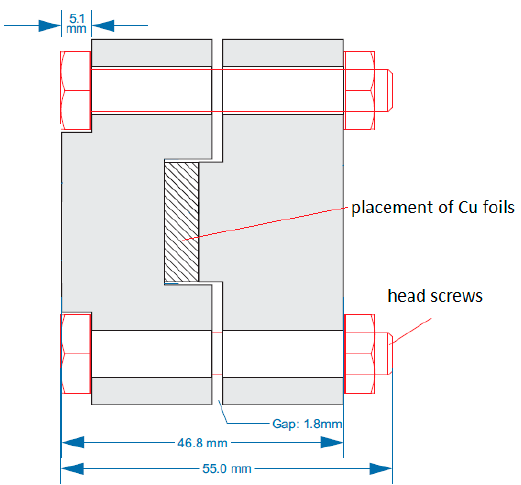
Figure 1. Technical drawing of the clamp used for the autogenous copper bonding.